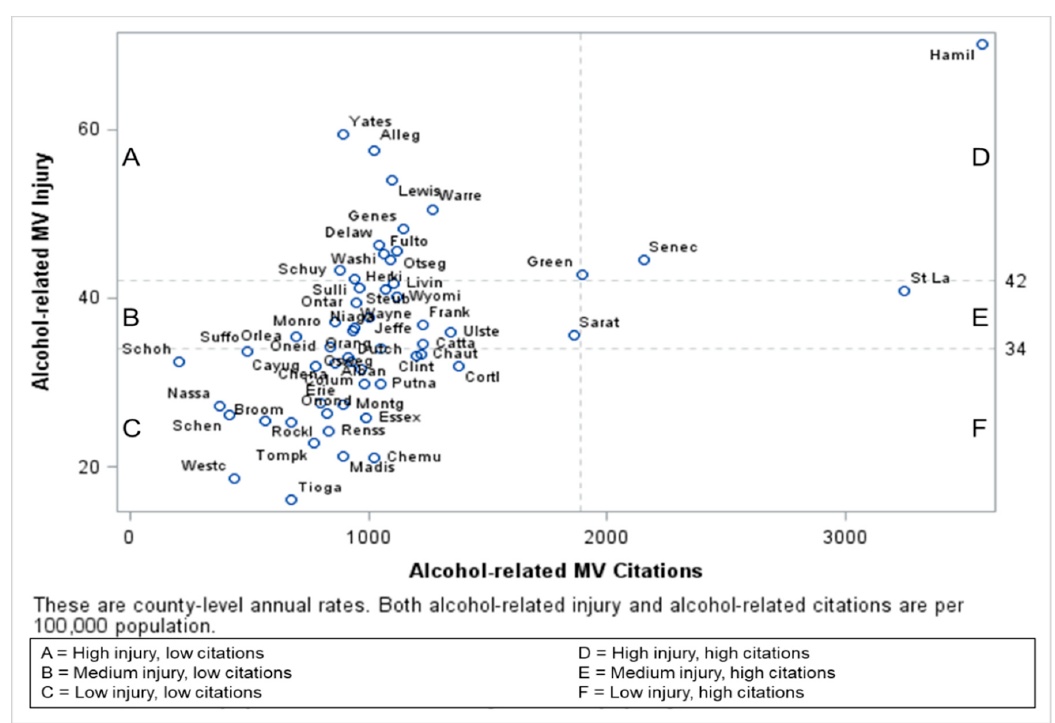
Figure 2. County-level annual rates of alcohol-related MV injury by alcohol-related citations in NYS per 100,000 population.